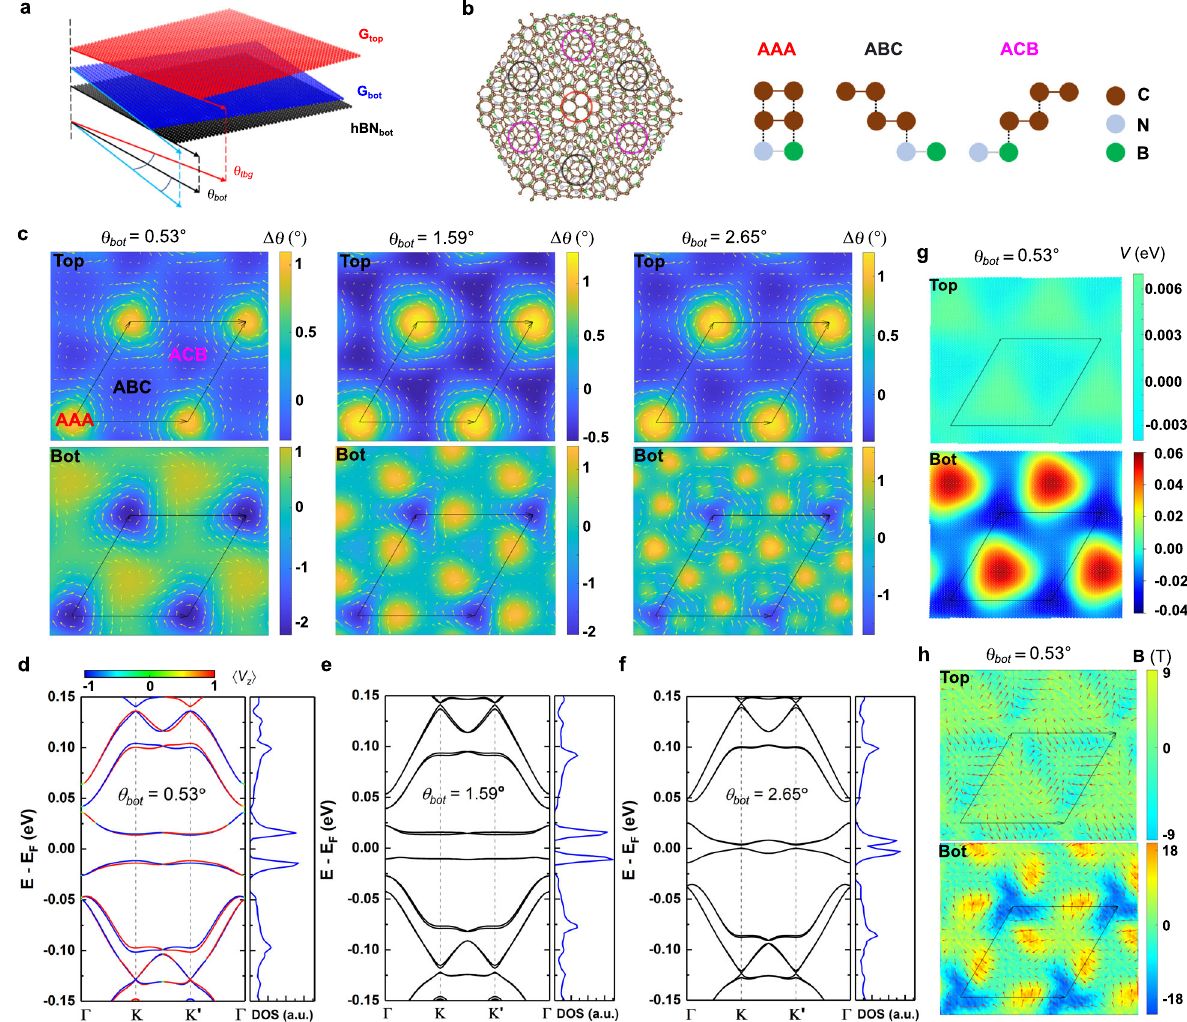
Fig. 1 Structural and electronic properties of TBG supported on hBN. a Schematics of the atomic con fi guration of TBG/hBN. b Top view of the atomic con fi guration of TBG/hBN. High-symmetry stacking regions of AAA, ABC, and ACB are marked by red, black, and purple circles. Carbon, boron, and nitrogen atoms are depicted in brown, green, and gray, respectively. c In-plane strain, u ( r ), in TBG/hBN with fi xed θ tbg = 1.05° and varying θ bot . The in-plane displacements are visualized with white arrows; the color data denote the local value of the in-plane twist of the atoms with respect to their original position ( Δ θ = ∇ × u ) with positive values corresponding to the counterclockwise rotation. The moiré supercell is outlined in black. d Band structure and density of states of TBG/hBN with θ bot = 0.53°. The color bar denotes the band for each valley h ^ V z i with h ^ V z i (cid:2) 1 if a state belongs to valley K and h ^ V z i (cid:2) (cid:3) 1 if a state belongs to valley K 0 . e , f Band structure and density of states of TBG/hBN with θ bot = 1.59° and θ bot = 2.65°, respectively. g The deformation potential V D and h pseudo-magnetic fi eld B = ∇ × A induced by lattice relaxations in the TBG/hBN with θ bot = 0.53°. The vector fi eld A ( r ) is visualized with red arrows in ( h ). The twist angle between bilayer graphene is fi xed to θ tbg = 1.05° in all